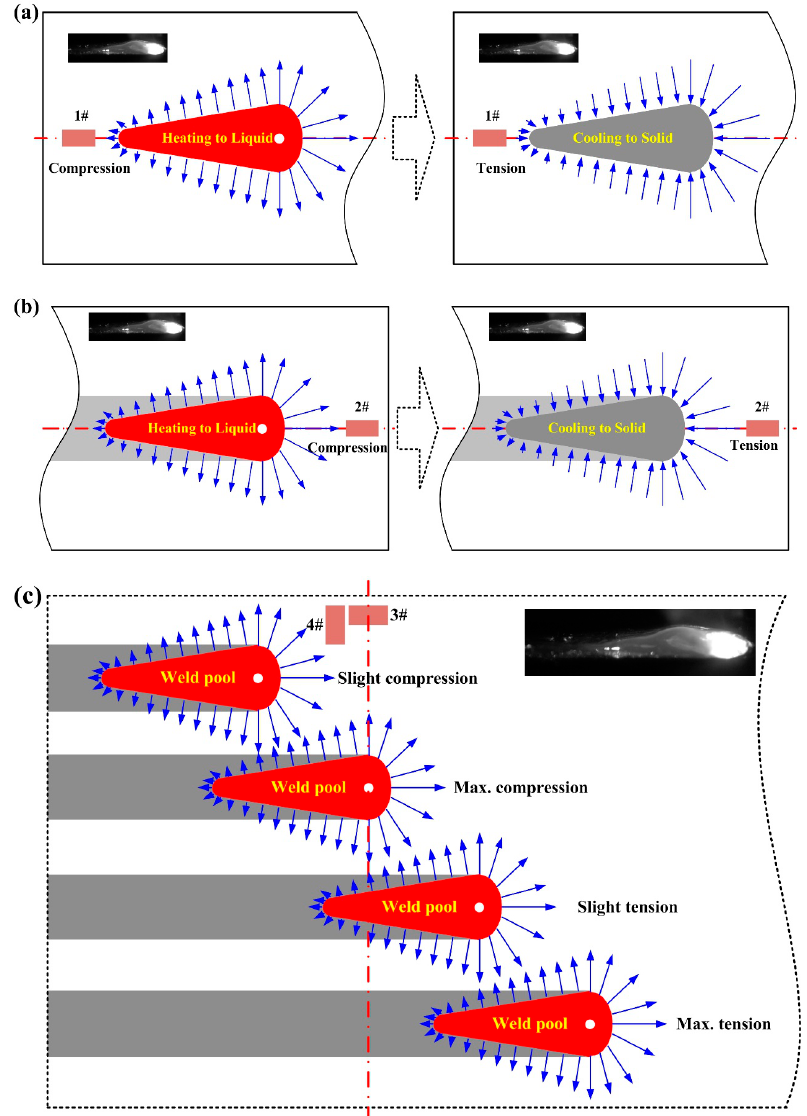
Figure 9. Formation procedure of transient strain for ( a ) 1#, ( b ) 2#, and ( c ) 3# and 4#.